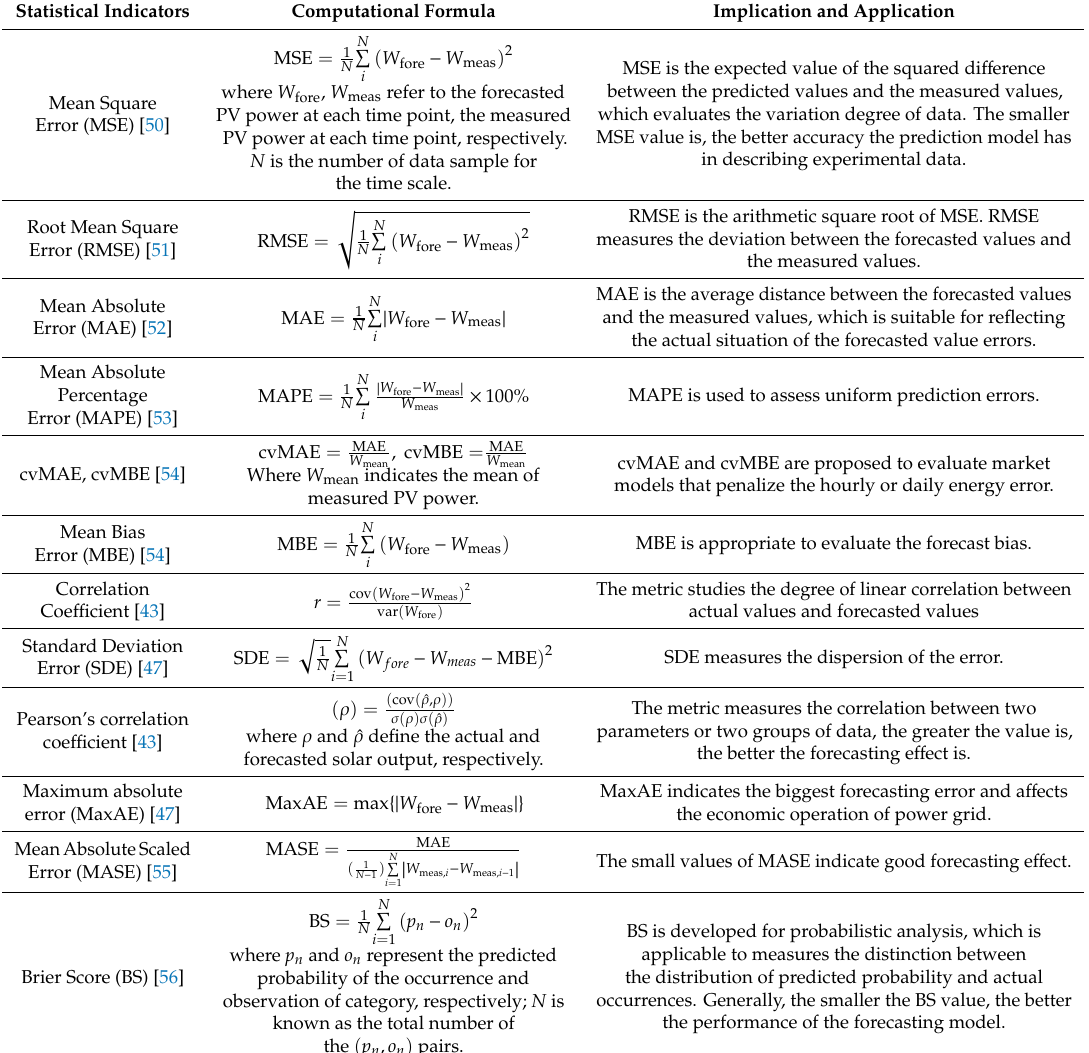
Table 2. Metrics assessment of solar PV power forecasting